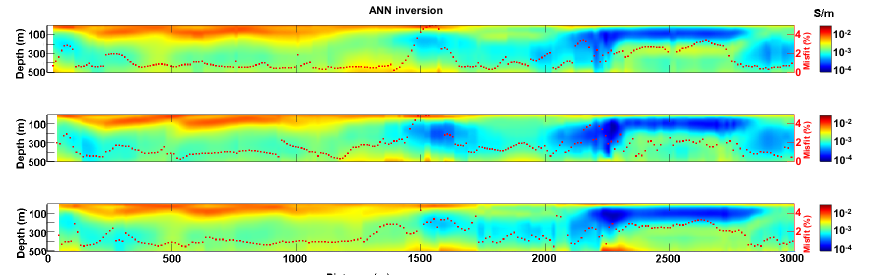
Figure 3. The inversion results obtained by applying the ANN trained on the training dataset (TD) in Figure 1 to the data generated by the conductive models in Figure 2. The data misfit between the calculated and the original measurements is shown for each individual 1D model location as a red dot (the corresponding axis is on the right in red).